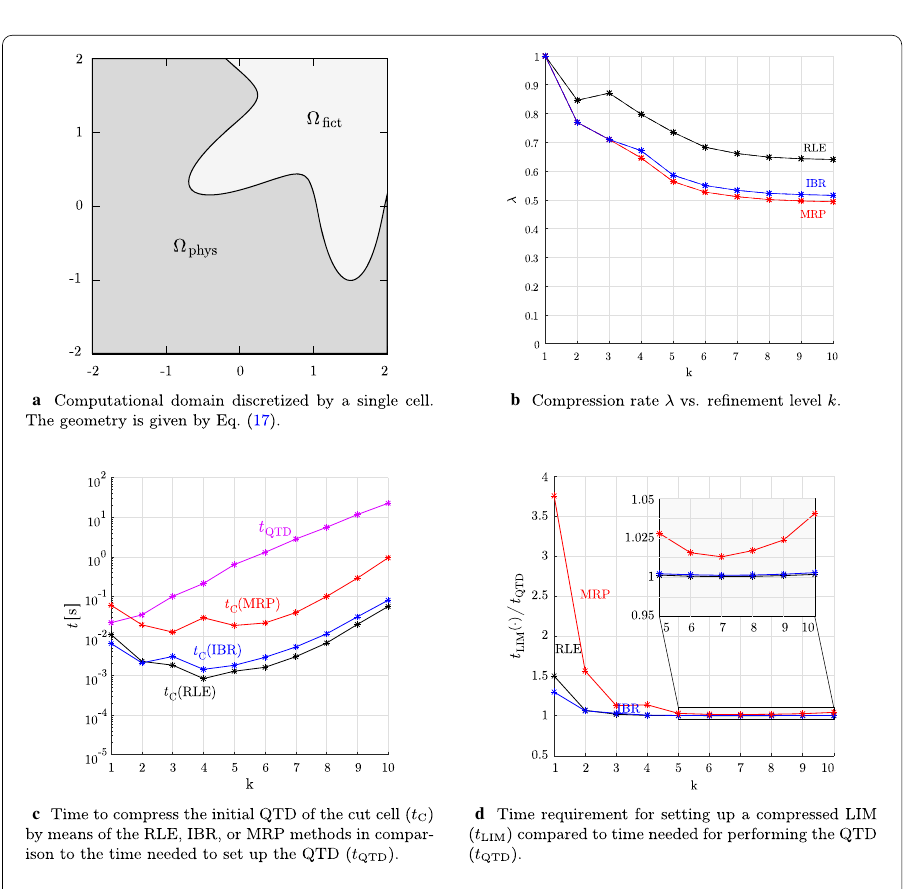
Fig. 13 Comparison of the performance and time requirements of the RLE, IBR and MRP algorithms for a given example